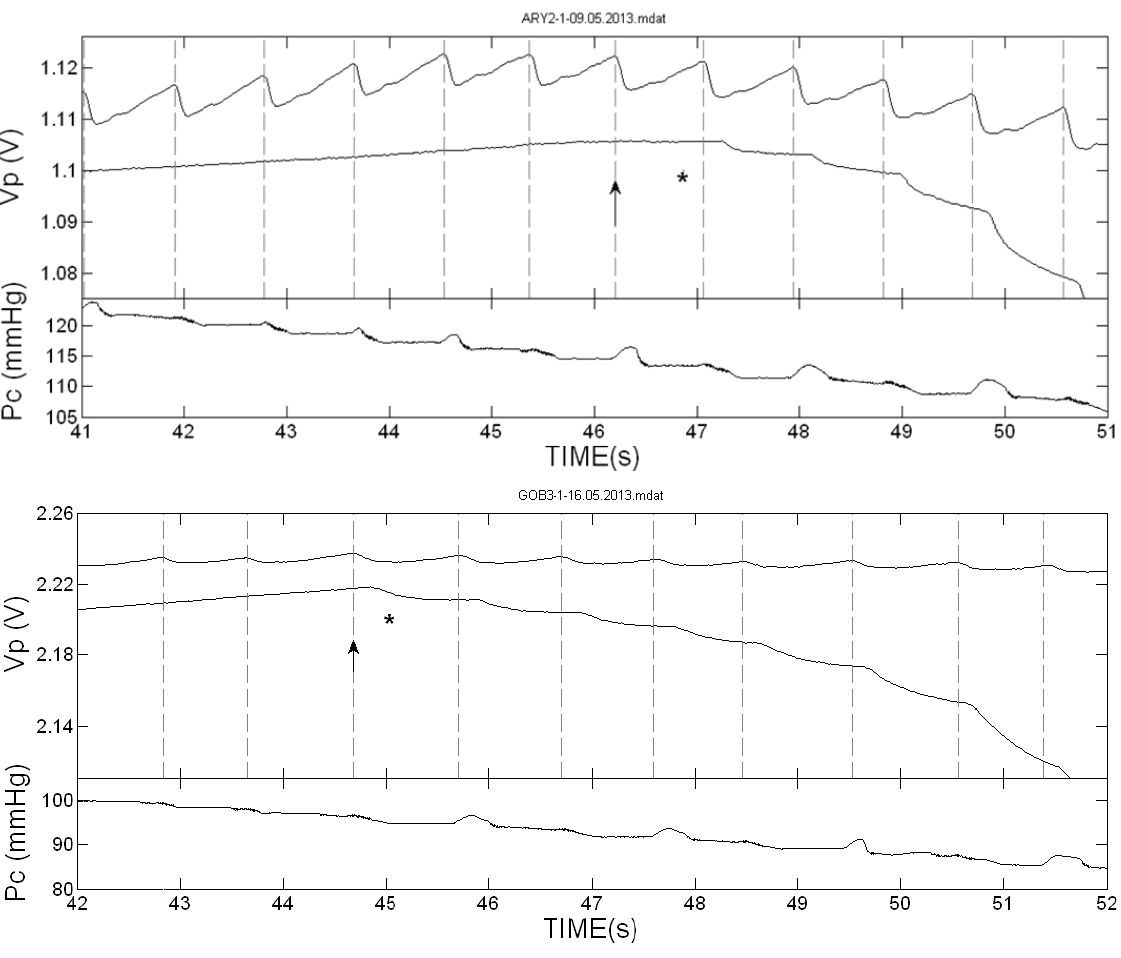
Figure 2. The PPG pulses (V ) in the two hands of two of the subjects during cuff P deflation for cuff pressures in the neighborhood of the SBP value. The vertical dotted lines indicate the start time of the systolic decrease in the cuff-free hand PPG pulses (the upper curve in each figure). The star indicates the time of the first detection of the Korotkoff sounds and the arrow indicates the start time of the free-hand PPG-pulse in which the first star appeared. In these two examinations, the first Korotkoff sounds were heard in the same heart-beat or nearly the same heart beat in which the first PPG pulses were